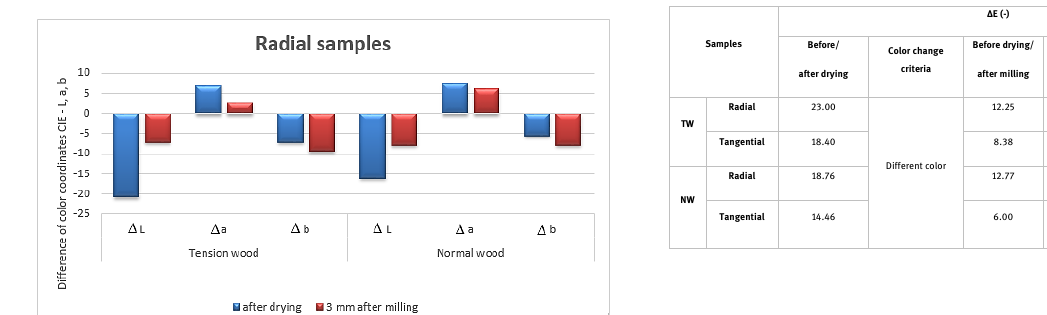
Table 2: Values of the color difference ∆